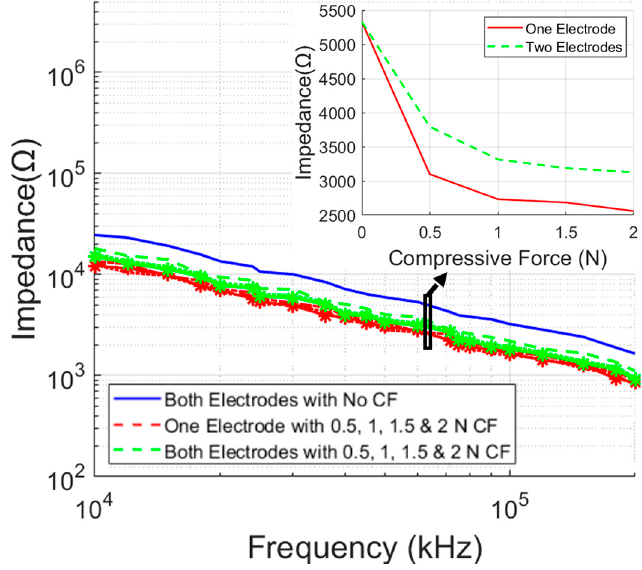
Figure 9. ETI measurement in final circular textile electrodes with varying compressive forces (without moisture applied).